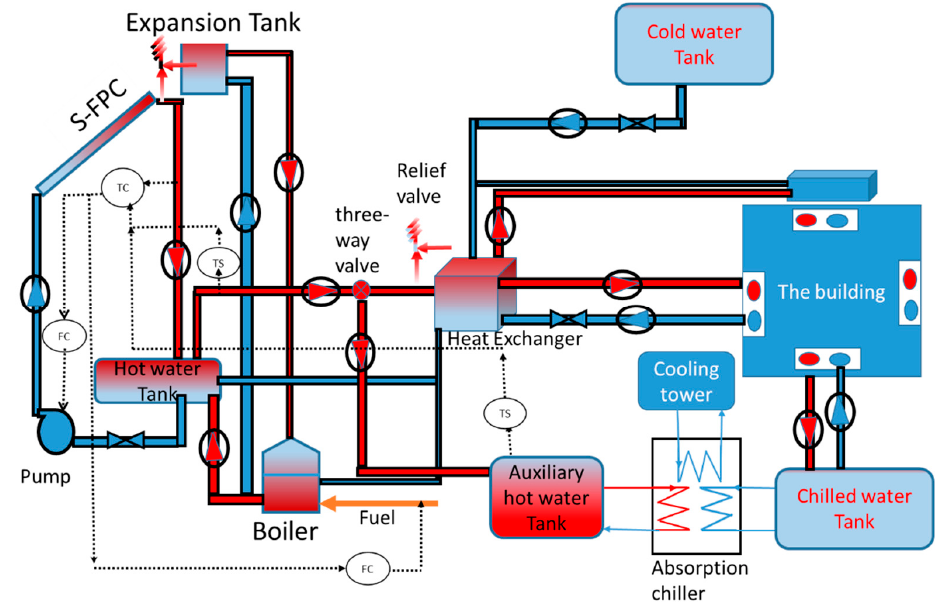
Figure 2. Block flow diagram of the combined boiler–solar water heating/cooling system.